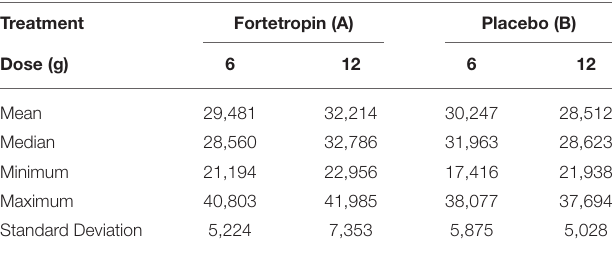
TABLE 5 | Combined mean, median, minimum, and maximum serum myostatin concentration of all groups (picogram/mL) at Time 0 (baseline) in all treatment